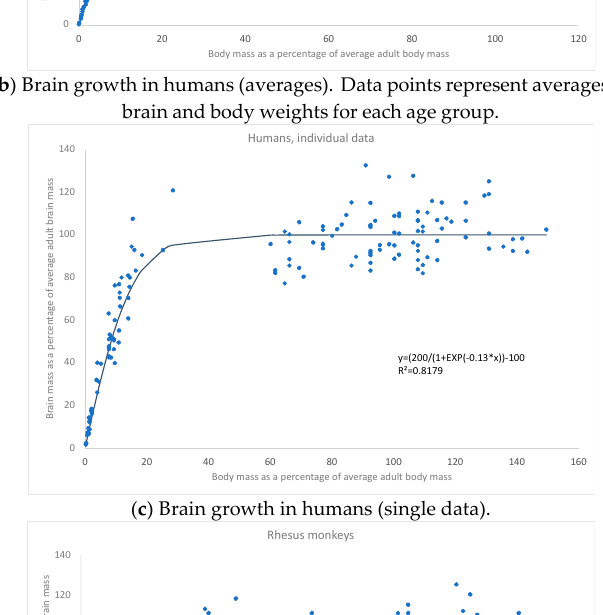
Body mass as a percentage of average adult body mass ( c ) Brain growth in humans (single data). Rhesus monkeys